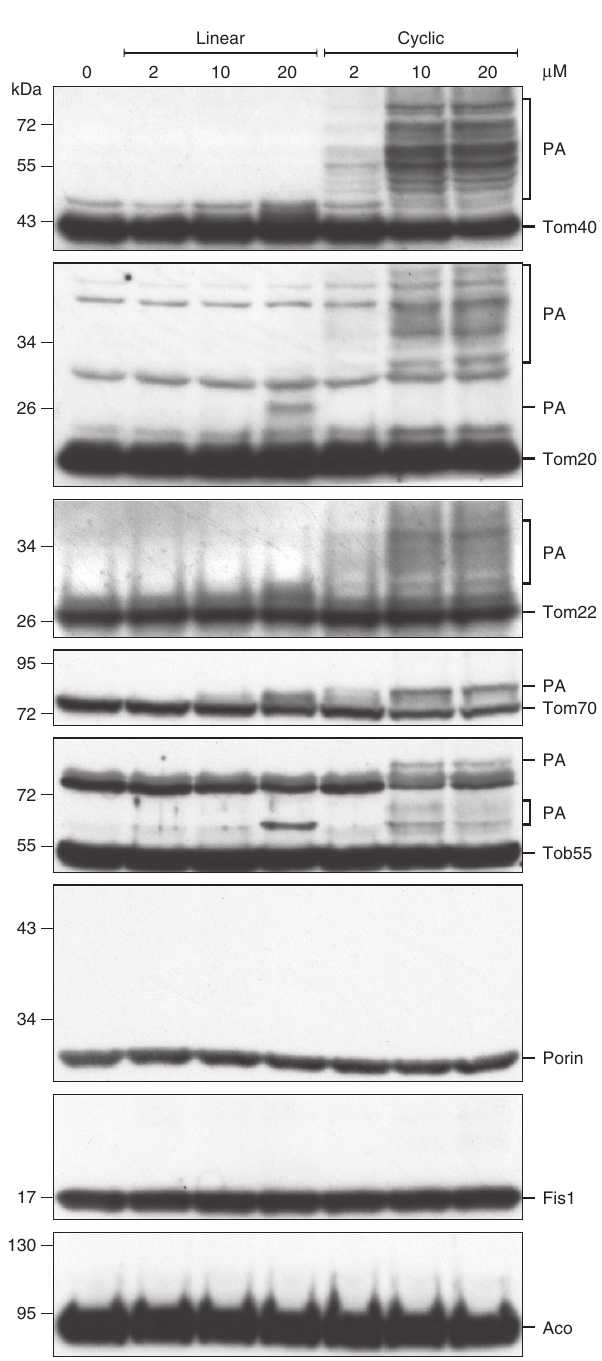
Figure 7 | The cyclic b -hairpin peptide can be cross-linked in organello to components of the TOM complex. Isolated mitochondria were incubated with a Bpa-containing linear or cyclic peptide at the indicated concentrations. After ultravoilet-induced cross-linking the samples were analyzed by SDS–PAGE and immunodecoration with antibodies against the indicated proteins. PA,